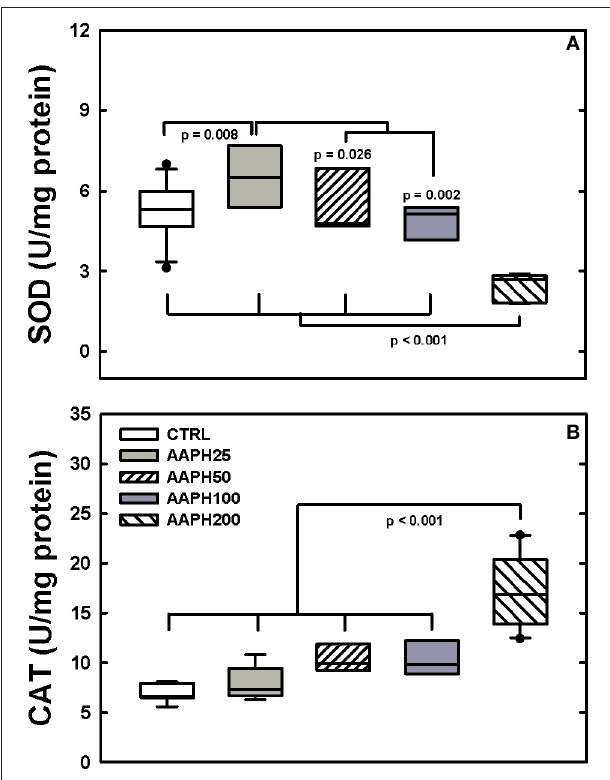
FIGURE 5 | Determination of enzymatic activity. (A) Superoxide dismutase (SOD). (B) Catalase (CAT). Animals exposed to saline solution (CTRL) or different amounts of 2,2 ′ -azobis (2-amidinopropane) dihydrochloride (AAPH25, 50, 100, and 200 mg/kg in saline solution). Panel (A) shows that SOD was smaller in AAPH200 group than in the other rats; AAPH25 presented SOD values larger than in the remaining groups. In panel (B) AAPH200 was larger than in the other groups that did not differ among themselves. Boxes show interquartile (25–75%) range, whiskers encompass 10–90% range, and horizontal lines represent median of 8 animals in each group. P -values are depicted.